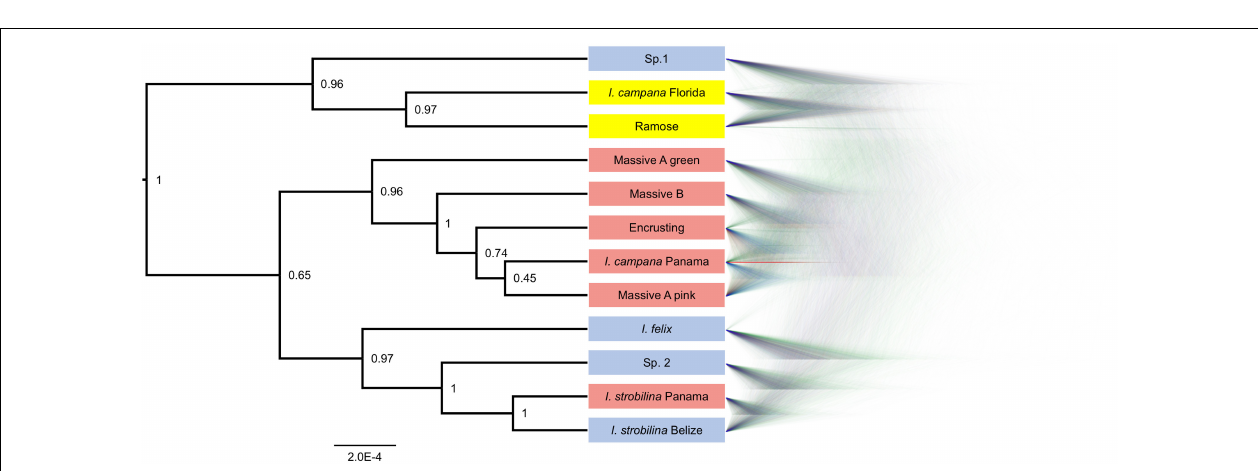
FIGURE 4 | Phylogeny produced via SNAPP for the best-supported species grouping model in BFD ∗ . Left : consensus tree with posterior probabilities as node labels. Right : Densitree visualization of posterior tree distribution displaying most frequent topology in blue and alternative topologies in green and red. Tip labels are colored by geography: blue for Belize, yellow for Florida, and red for Panama.